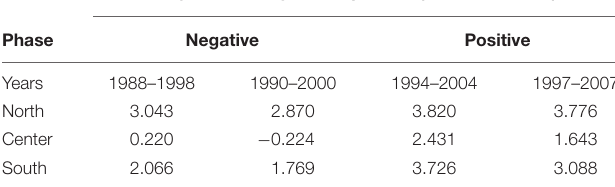
TABLE 2 | Resulting NPV for four different periods of representative sites matching with negative (1988–1998, 1990–2000) and positive (1994–2004, 1997–2007) phases of the